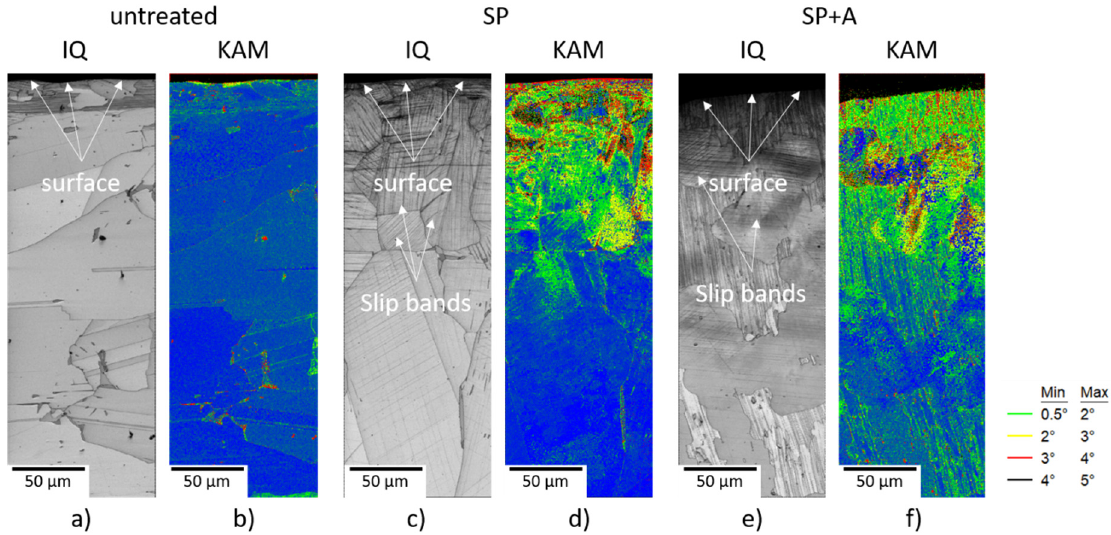
Figure 2. EBSD Image Quality (IQ) and Kernel Average Misorientation (KAM) maps of ( a , b ) untreated material, ( c , d ) SP material, and ( e , f ) SP+A material.